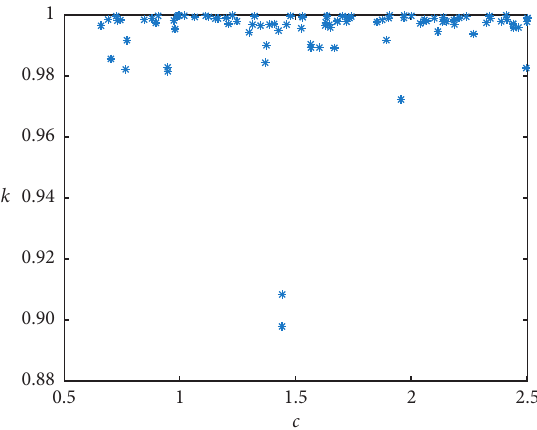
Figure 5: K vs. c for PM2.5